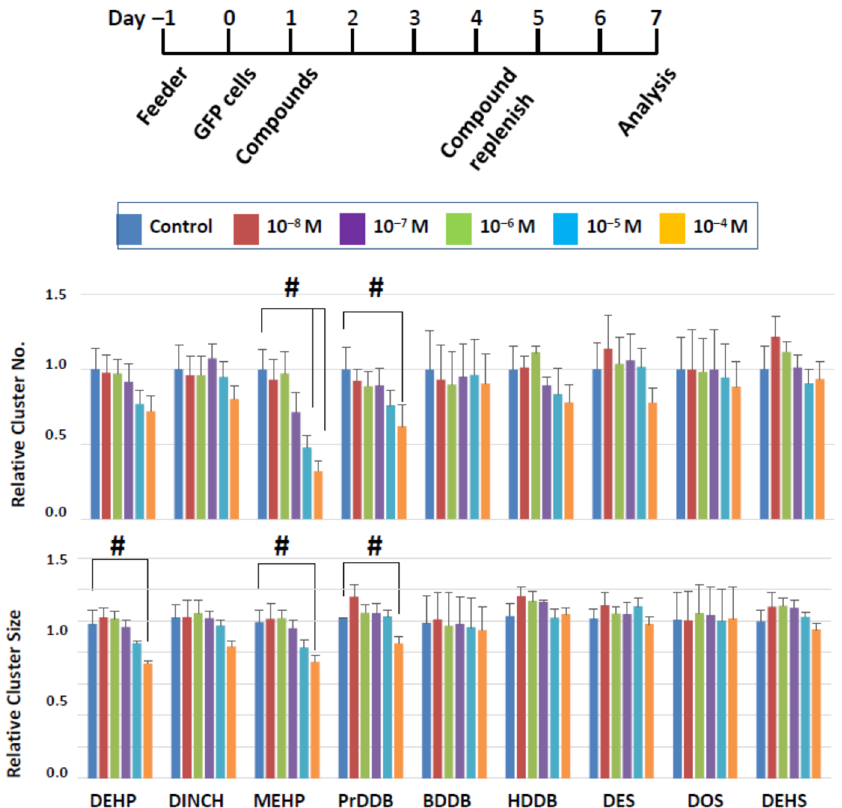
Figure 7. Cluster numbers and sizes after a 6-day exposure to select plasticizing compounds. The data are normalized to the results of control (DMSO) treatment. Hash signs (#) denote significant differences ( p < 0.05). A significant reduction in cluster number and size is seen when clusters were treated with MEHP or PrDDB, while DEHP showed a negative impact on cluster size alone .